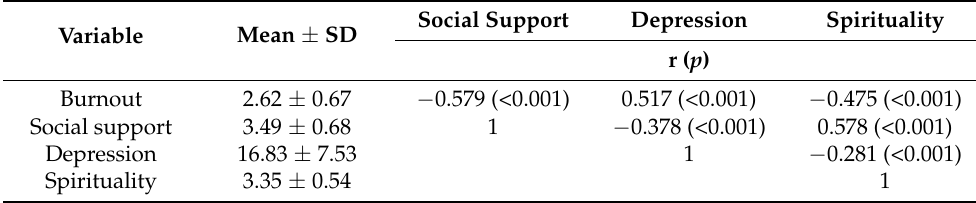
Table 2. Correlations among study variables (n =